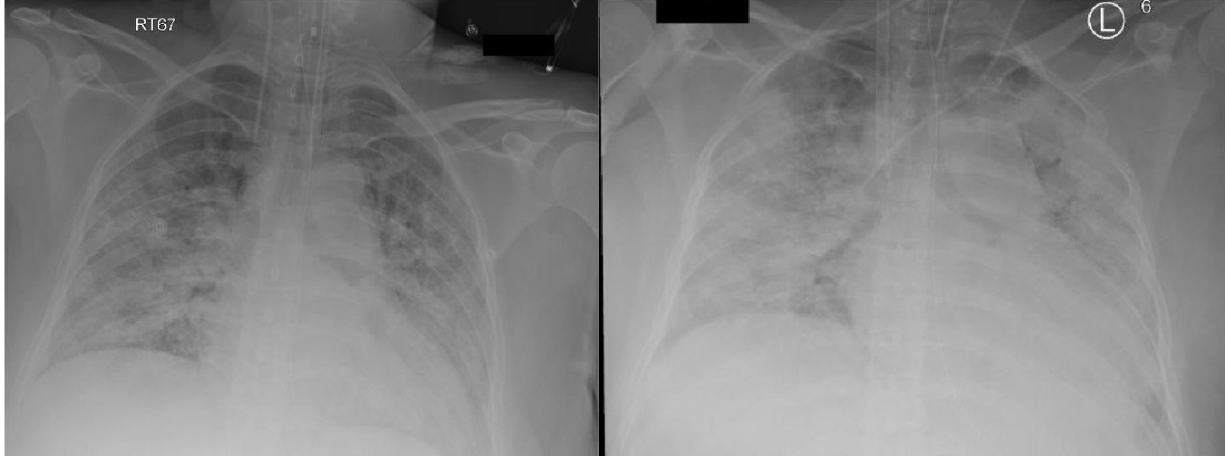
Figure 1. CXR (left) on admission, (right) on ECMO day 0. Figure 1. CXR ( left ) on admission, ( right ) on ECMO day 0. Over the 12 h following admission, her hypoxemia worsened, despite trials to optimize oxygenation via Atracurium infusion, recruitment maneuvers, and increasing both